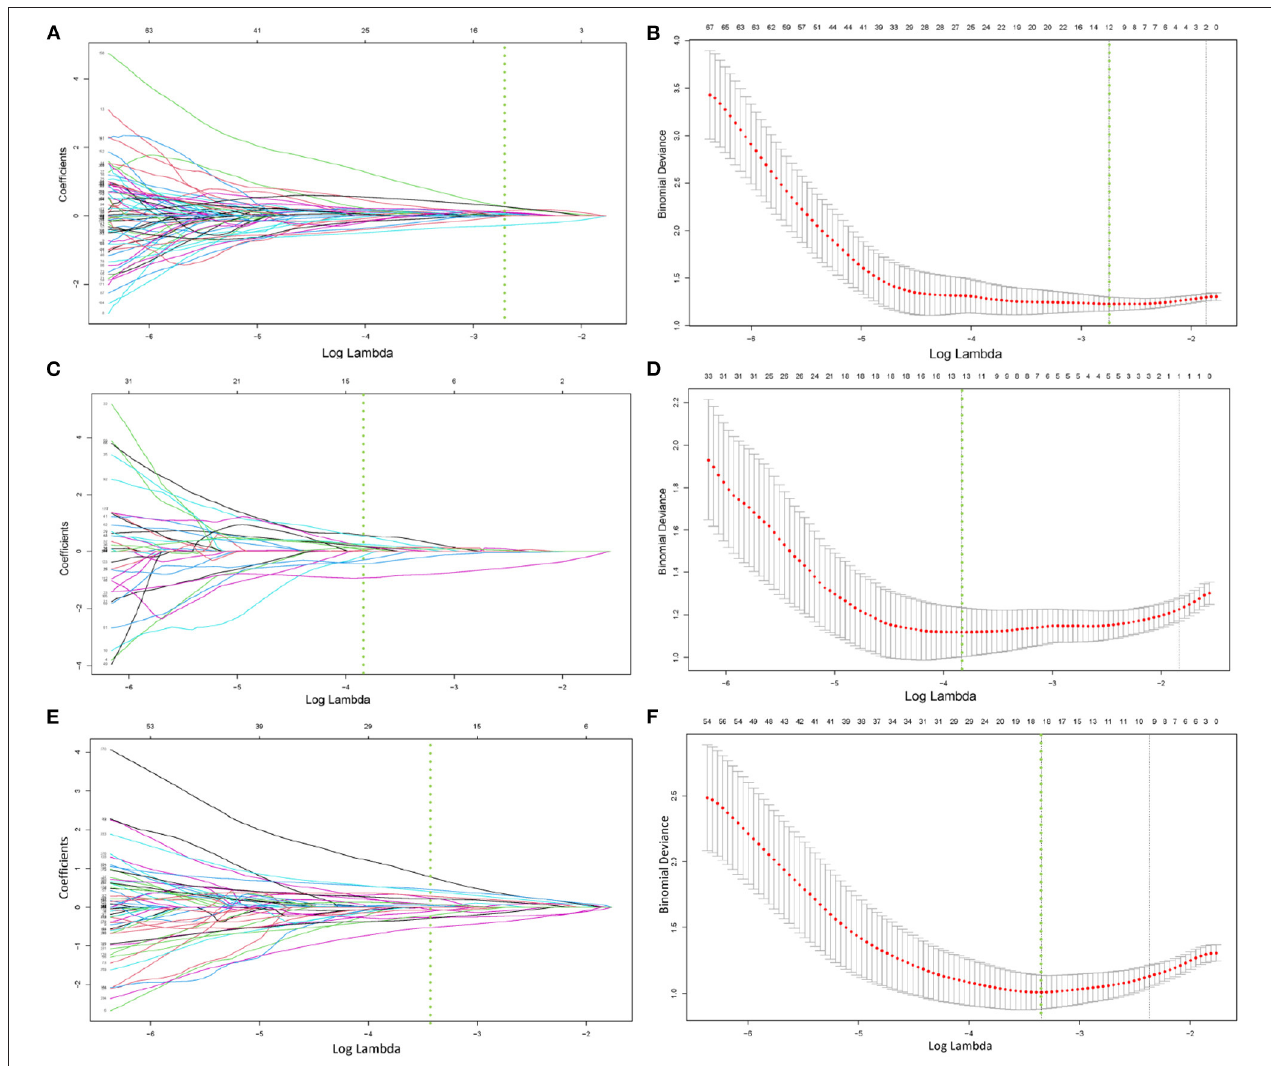
FIGURE 3 | (A–F) demonstrated the specific process of least absolute shrinkage and selection operator (LASSO) regression analysis screening features for CT model, SPECT model, and ComModel, respectively. (A,C,E) showed the process of features selection. The vertical line was plotted at the optimal λ of 0.064, 0.025, and 0.035 for CT, SPECT, and ComModel, respectively. Twelve, thirteen, and eighteen factors with non-zero coefficients were finally selected for CT, SPECT, and ComModel, respectively. (B,D,F) showed that features selection was performed by 10-fold cross-validation with the criterion of minimum